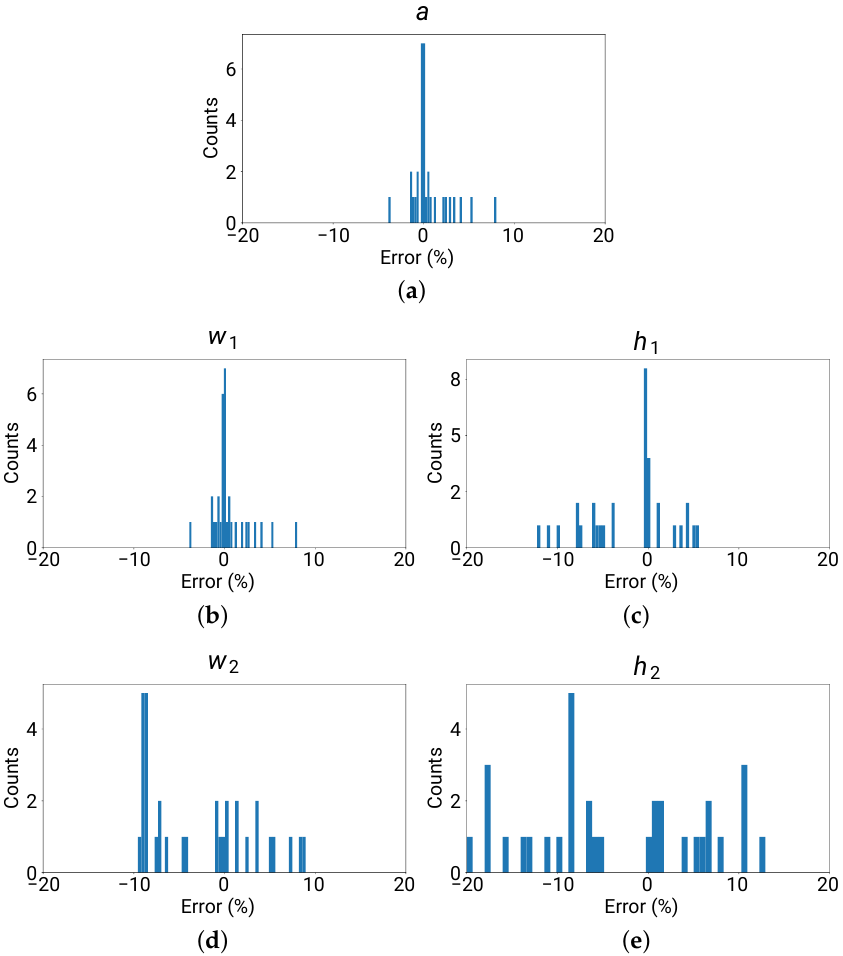
Figure 8. Error distribution for each of the five parameters of the 33 sets of testing data. ( a – e ) plot the error distributions for the parameters a , w 1 , h 1 , w 2 , and h 2 , respectively. The error metrics in Equation (7) were